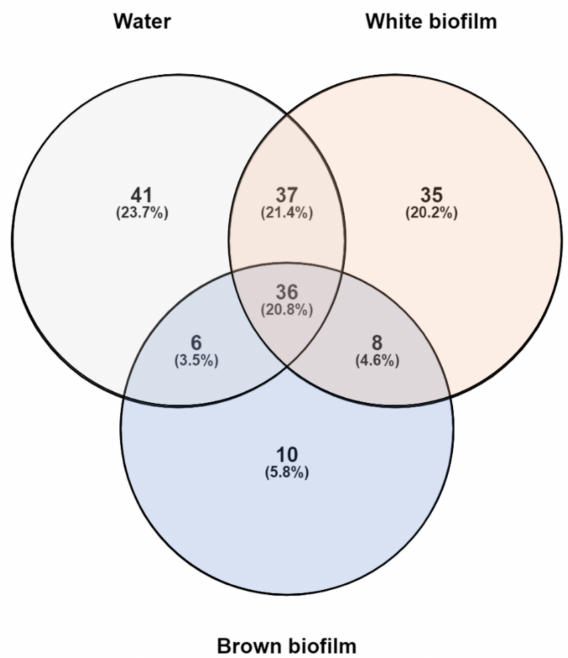
Figure 5. Prokaryotic OTU distribution in water, white biofilm, and brown biofilm samples from the Smrdljivec spring. The Venn diagram indicates the number of distinct and shared OTUs. The above OTUs corresponded to seven bacterial phyla out of which Proteobacteria dominated all samples (Figure 6). In the water sample, Bacteroidetes (9.5%) and Acti- nobacteria (5.4%) were abundant alongside Proteobacteria (84.6%). In the white biofilm sample, Actinobacteria (7.0%) were abundant in addition to Proteobacteria (88.9%). The brown biofilm was the least diverse at phylum level and Proteobacteria (97.0%) were overwhelmingly dominant, followed by Bacteroidetes (2.7%).